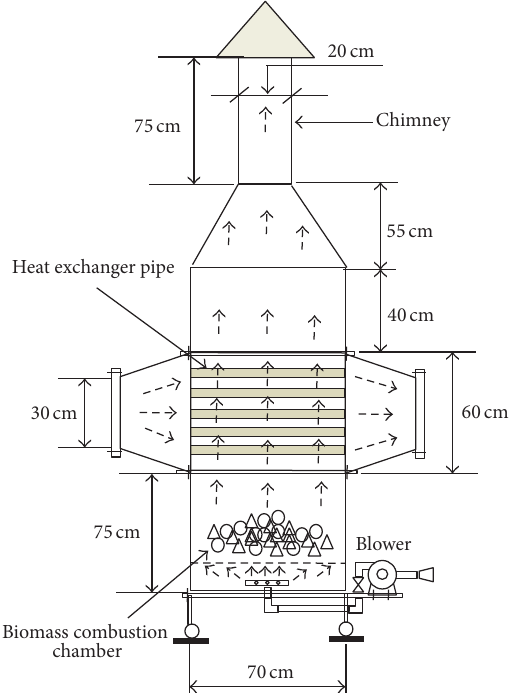
Figure 4: Dimensions of biomass furnace.